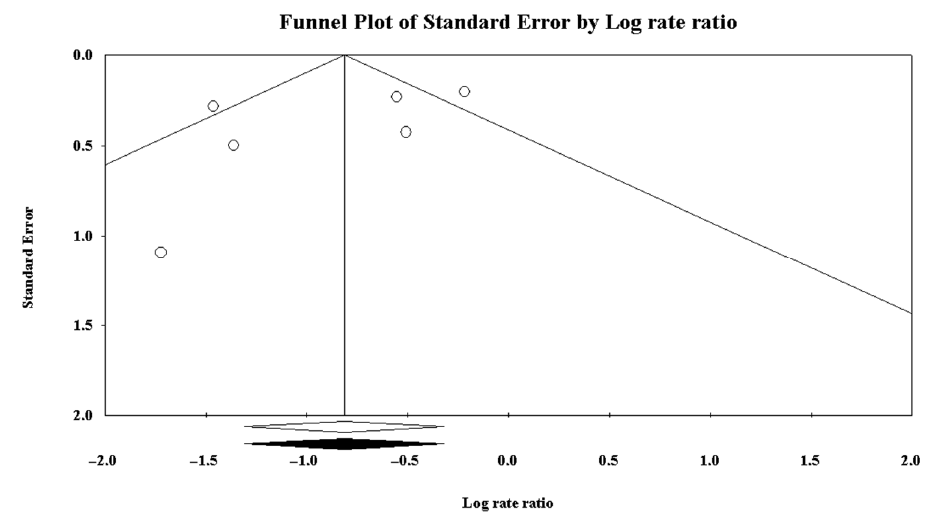
Figure 3. The funnel plot did not identify heterogeneity among the studies analysed. The x-axis Scheme 0. (95%CI 0.282–0.968), p = 0.039, whereas it was 0.379 for the randomized controlled trials (95%CI 0.149–0.968), p = 0.042.